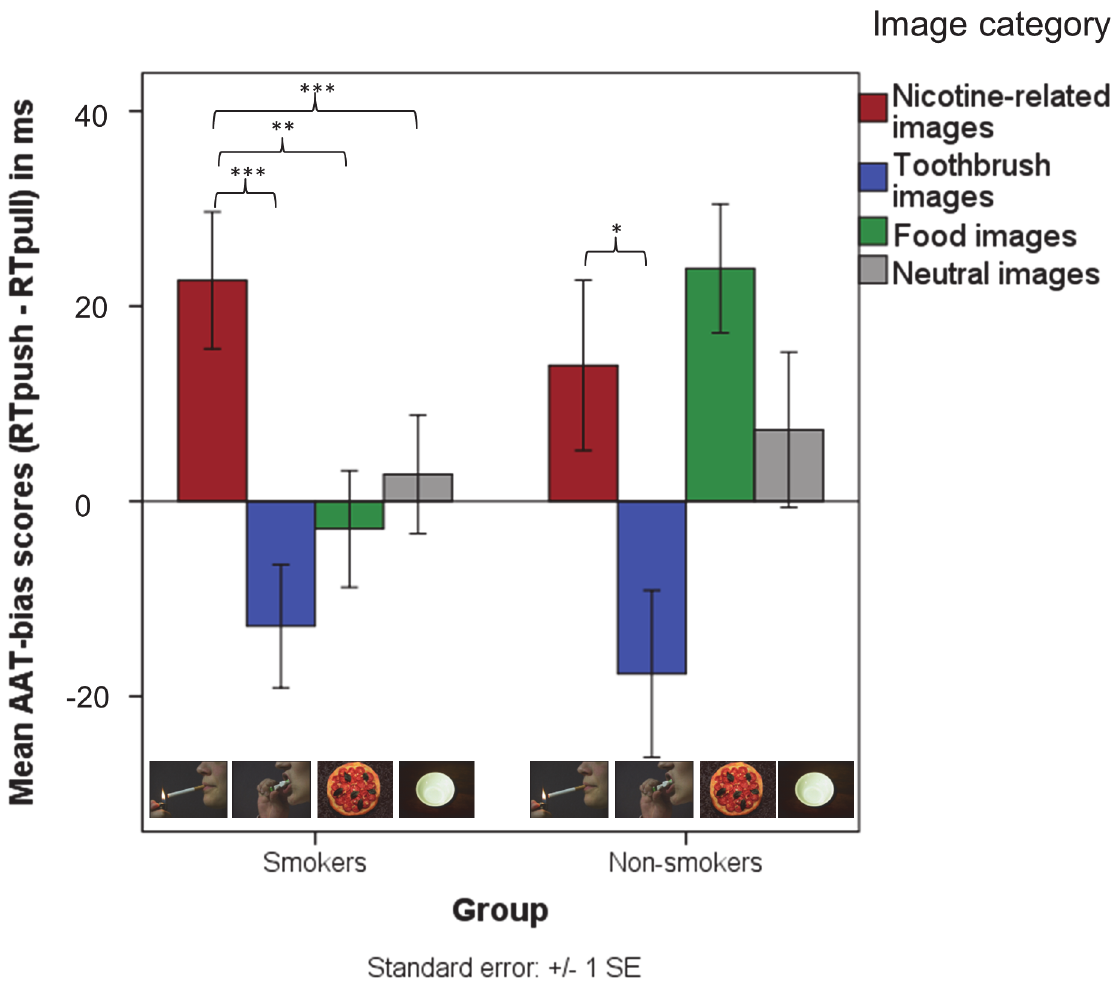
Figure 2. Mean AAT-bias scores for nicotine-related images, images of toothbrushes, food images and neutral images, in smokers and non- smokers. A positive score indicates an approach tendency, a negative an avoidance tendency. Error bars correspond +/ − 1 standard error. * p < .05; ** p < .01; *** p <